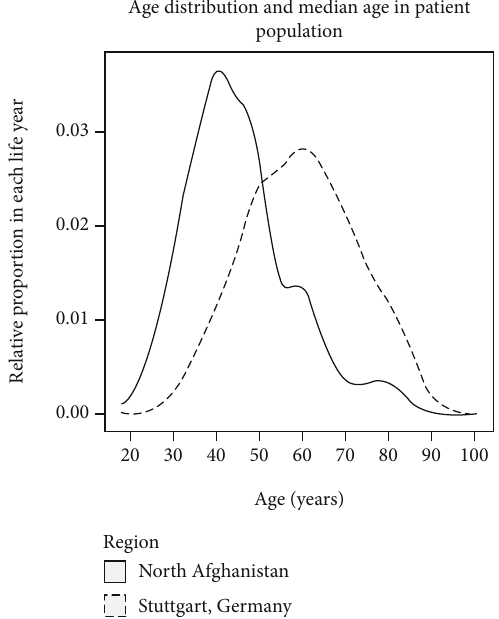
Figure 2: Age distribution in breast cancer patients in Afghanistan and